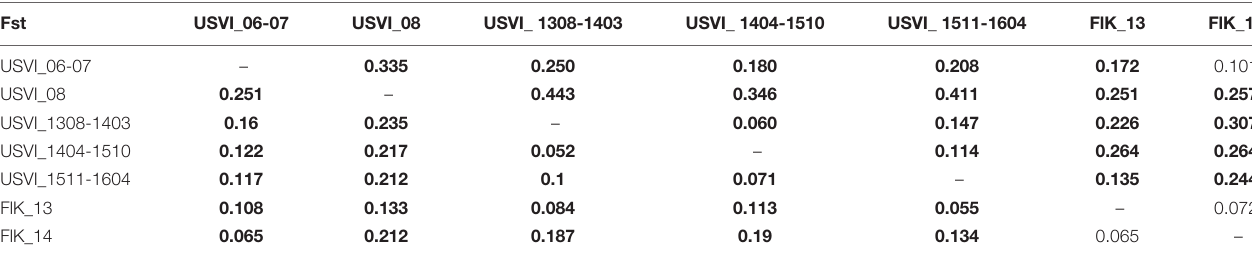
FIGURE 3 | Principal component analysis (PCA) of genetic data from the Florida Keys (FlK) 2013 and 2014, USVI 2006, 2007 and 2008, and approximate monthly groups from the high-resolution sampling period at USVI (1308-1604). Colors correspond to the clusters suggested by the STRUCTURE analyses. TABLE 2 | F ST values below the diagonal and Jost’s D values above the diagonal (based all seven